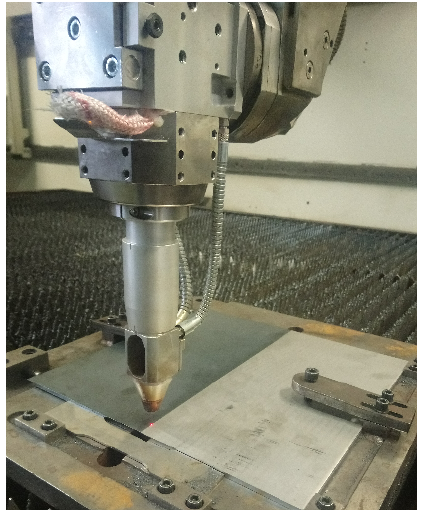
Figure 6: Experimental laser welding